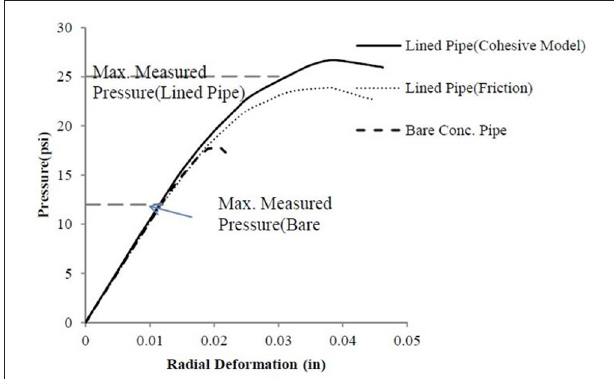
FIGURE 12 | Pressure deformation curve of bare and lined concrete pipes.